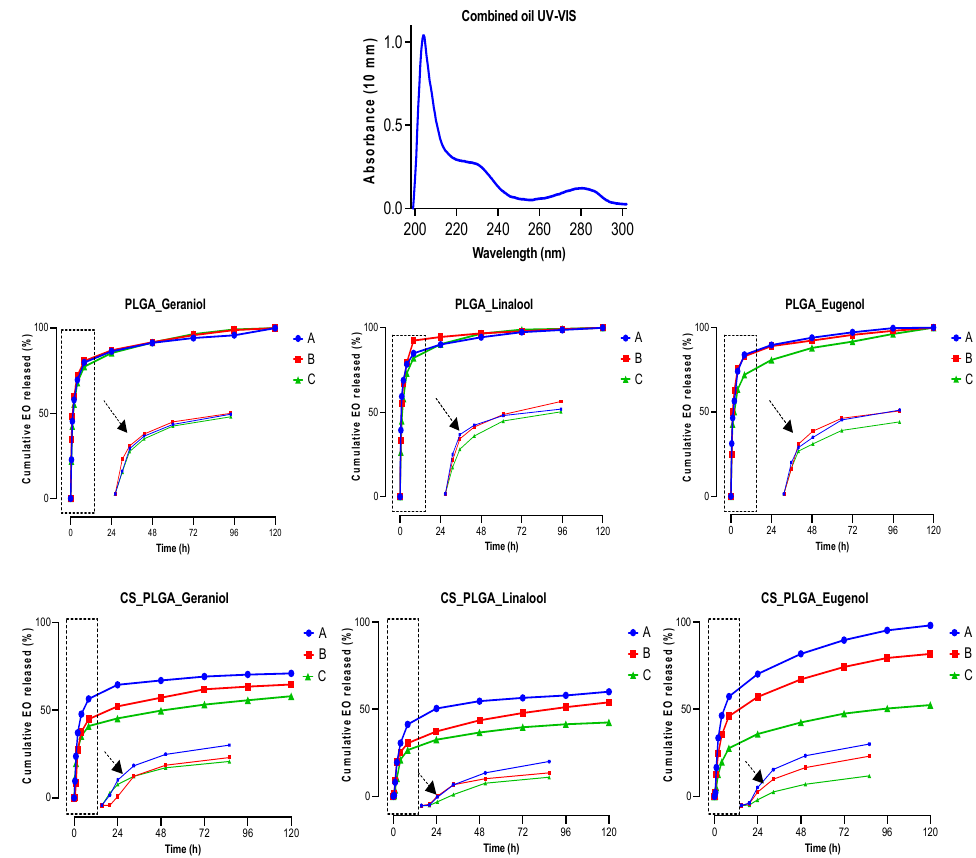
Figure 9. In vitro release kinetics of EO components from the uncoated and CS-PLGA particles over 120 h in hydrochloric acid-potassium chloride buffer, acetate buffer, and phosphate buffer saline denoted as A, B and C, respectively. The data are presented as average cumulative EO components release % with standard errors (1.4:2.8%). The top graph shows the absorbance band of geraniol, linalool, and eugenol detected at wavelengths of 210, 228, and 282 nm, respectively.